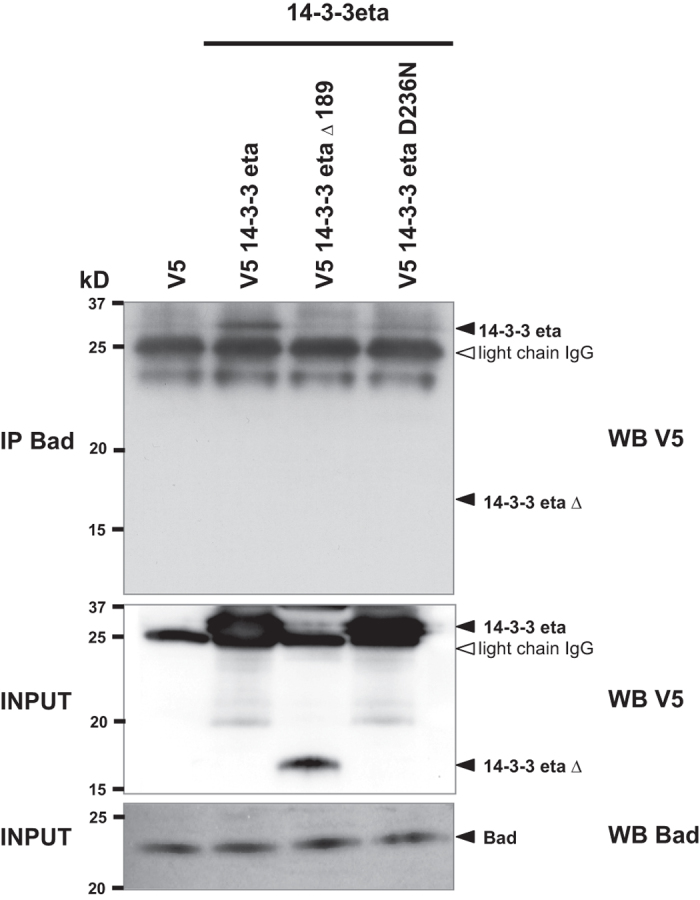
Impact of YWHAH variants on Bad interaction. After transfection of empty vector pcDNA-V5, 14-3-3eta-V5, 14-3-3eta∆189-V5 and 14-3-3D236N-V5 in HeLa cells, the production of the protein was verified by western blotting (Input, middle panel), and immunoprecipitation studies were performed with the Bad antibody. The presence of 14-3-3eta in the Bad complex was shown by immunoblot with the rabbit anti-V5 antibody (IP Bad, top panel). The antibody used for the immunoblot analysis is denoted at the right side. Cell lysates were immunoblotted with the Bad antibody as a control (Input, bottom panel).